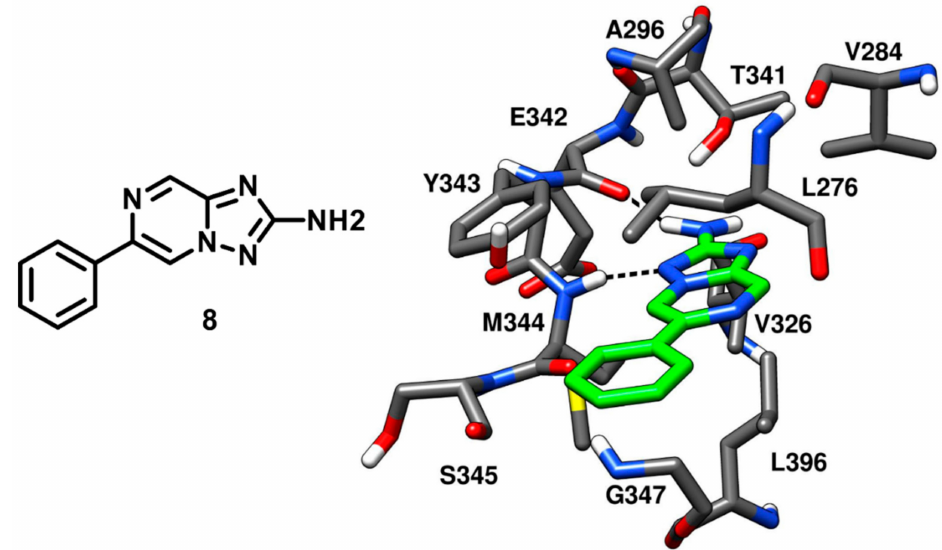
Figure 9. 2D structure of 8 and X-ray structure of c-Src kinase in complex with 8 (PDB ID: 4FIC). Active site residues of c-Src kinase and the enzyme–inhibitor H-bond interactions are